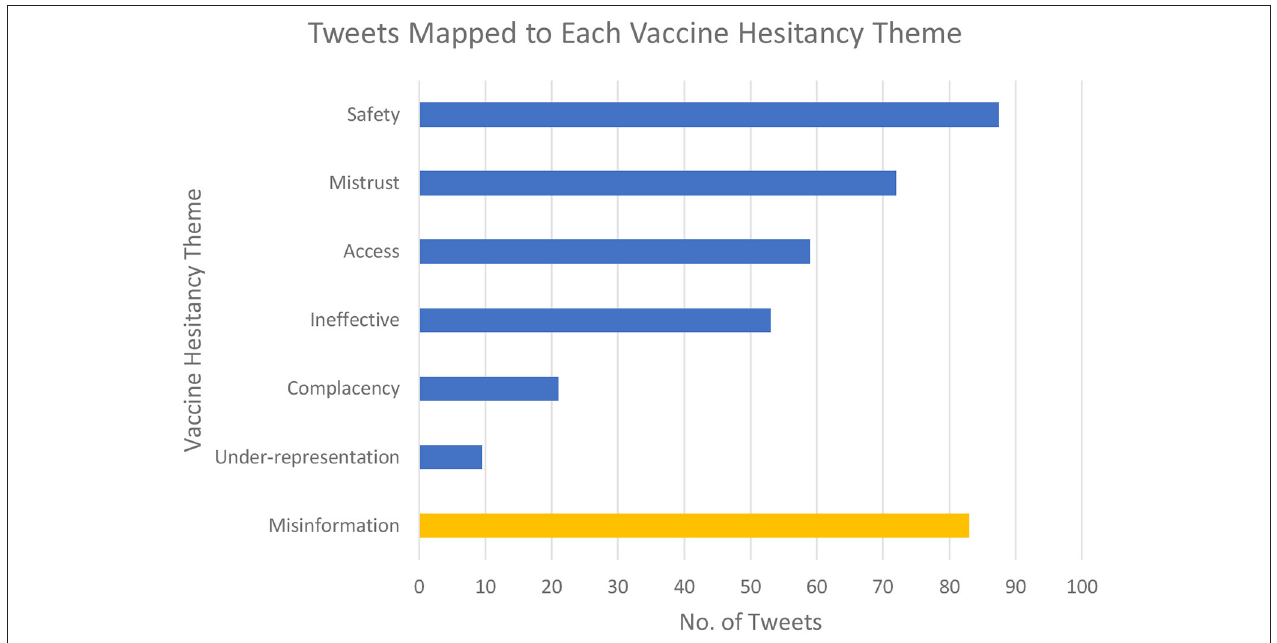
FIGURE 3 | Chart to quantify the results of the coding exercise. of users were posting inaccurate information to encourage vaccination. For example, tweets were identified that shared false statistics on the relative risk of blood clots after taking the AstraZeneca vaccine compared to taking the contraceptive